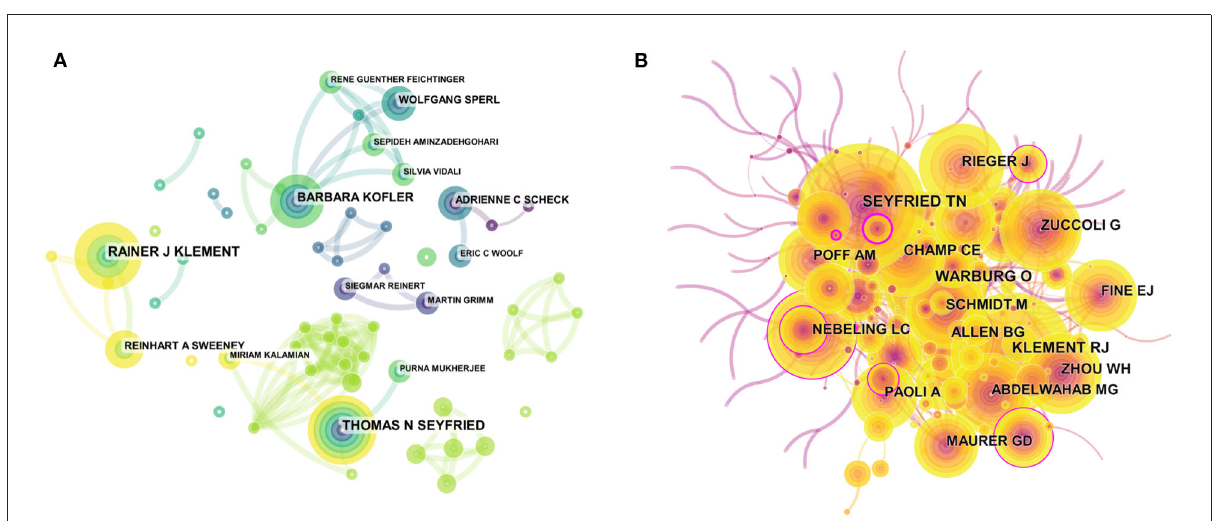
FIGURE4 Visualization map of authors/cited-authors. (A) Visualization map of authors. (B) Visualization map of cited-authors. Nodes indicate authors, and the lines between nodes indicate collaborative relationships. The larger the node area, the greater the number of publications by that author or cited